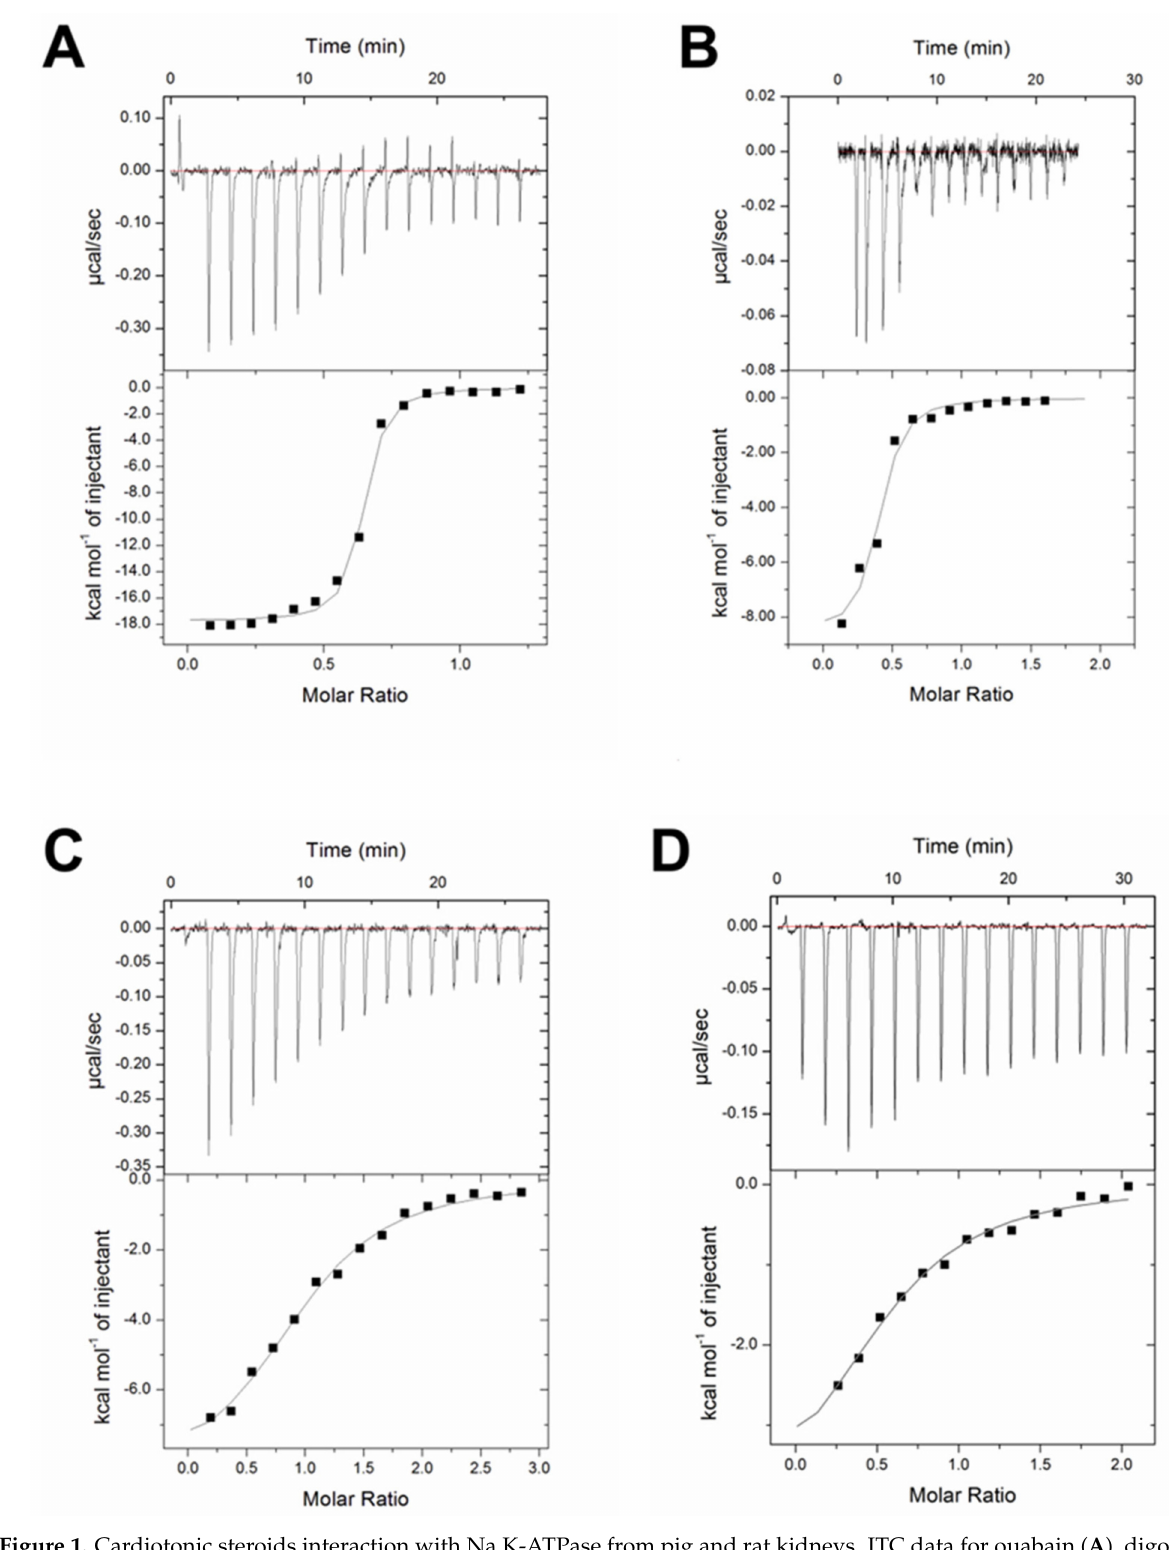
Figure 1. Cardiotonic steroids interaction with Na,K-ATPase from pig and rat kidneys. ITC data for ouabain ( A ), digoxin ( B ), and marinobufagenin ( C ) binding to α 1S − Na,K-ATPase in E2P—conformation and ouabain ( D ) binding to α 1R-Na,K- ATPase in E2P—conformation. Titration curves (upper panel) and binding isotherms (lower panel) are shown for the Na,K-ATPase interaction with ouabain, digoxin and marinobufagenin at 37 ◦ C, pH 7.4. Approximation of the isotherm was made using a model with one type of binding site (continuous